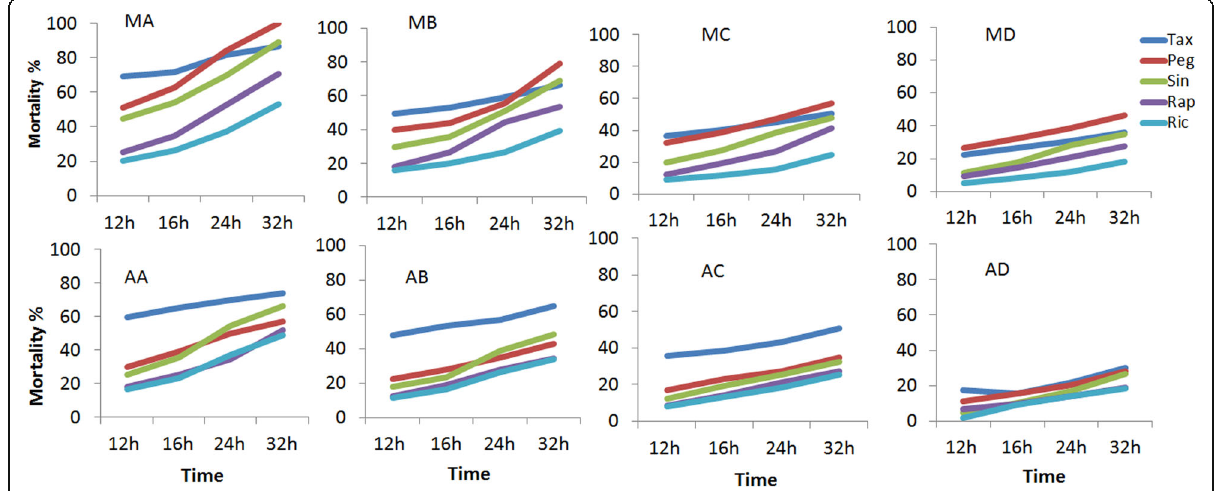
Fig. 2 Effect of different aqueous (A) and methanolic (M) extracts at various concentrations ( a 80%, b 60%, c 50%, and d 40%) on mortality of M. incognita juveniles (J2s) during exposure times. Tax T. baccata , Peg. P. harmala , Sin . S. arvensis , Rap . R. raphanistrum , Ric R. communis